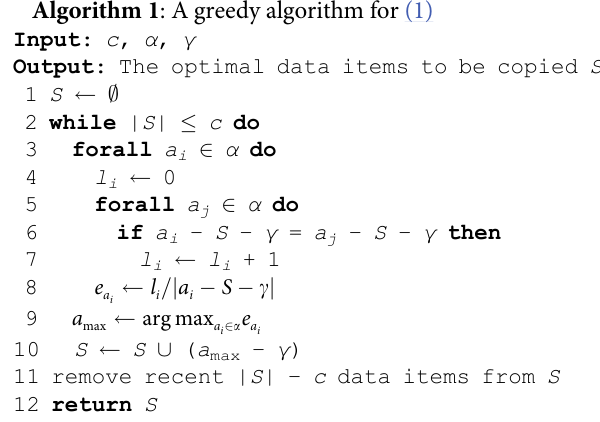
Algorithm 1 : A greedy algorithm for